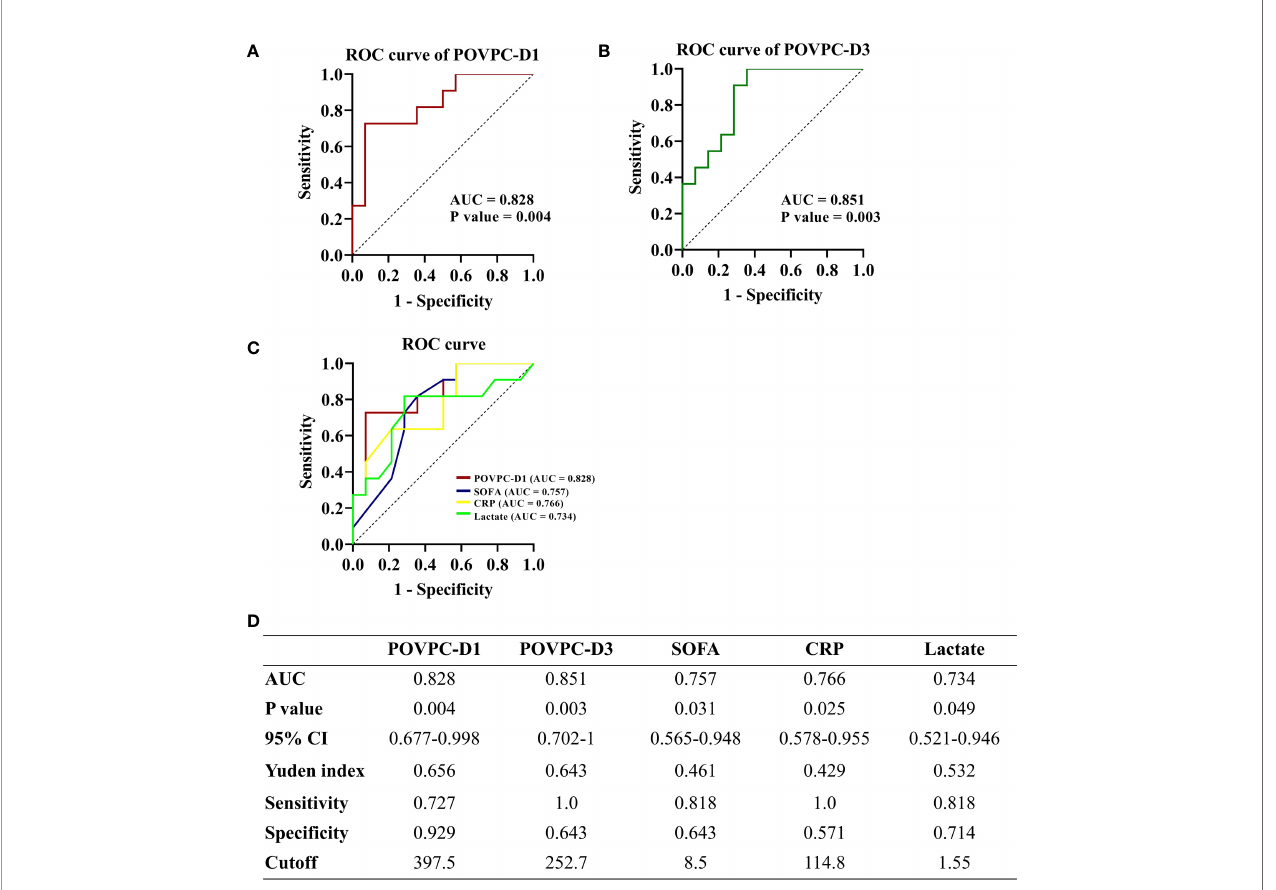
FIGURE 5 | Predictive ability of HDL POVPC for 28-day mortality of septic patients. ROC curve for HDL POVPC-D1 and POVPC-D3 in diagnosis of the sepsis (A, B) . ROC curves for POVPC-D1, SOFA score, CRP, and lactate in prediction of the 28-day mortality in septic patients (C) , and the Youden ’ s index in order to maximize both sensitivity and speci fi city (D) . ROC, receiver operating characteristic; AUC, area under the curve; CI, con fi dence interval; HDL, high-density lipoprotein; SOFA, sequential organ failure assessment; CRP, C-reaction protein; POVPC, 1-palmitoyl-2-(5-oxovaleroyl)-sn-glycero-phosphatidylcholine; D1, Day 1; D3, Day 3.